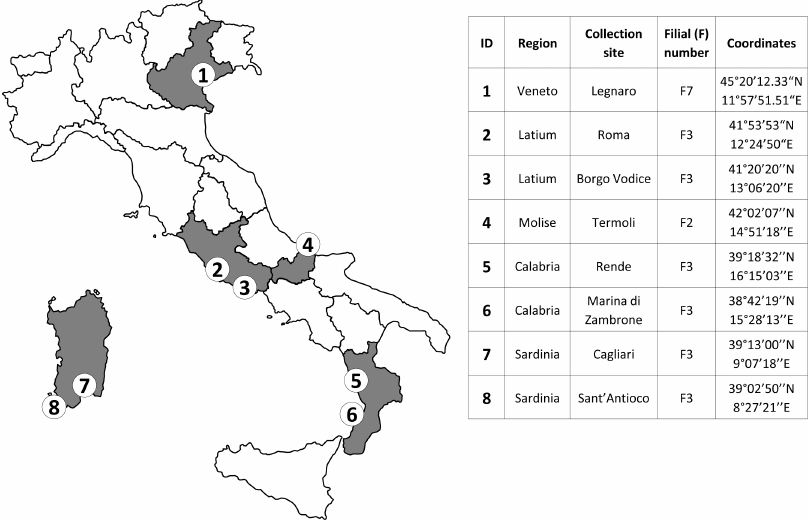
Fig 1. Description of Aedes albopictus populations. Locations and filial generations (F) of the Italian Ae . albopictus populations experimentally infected with